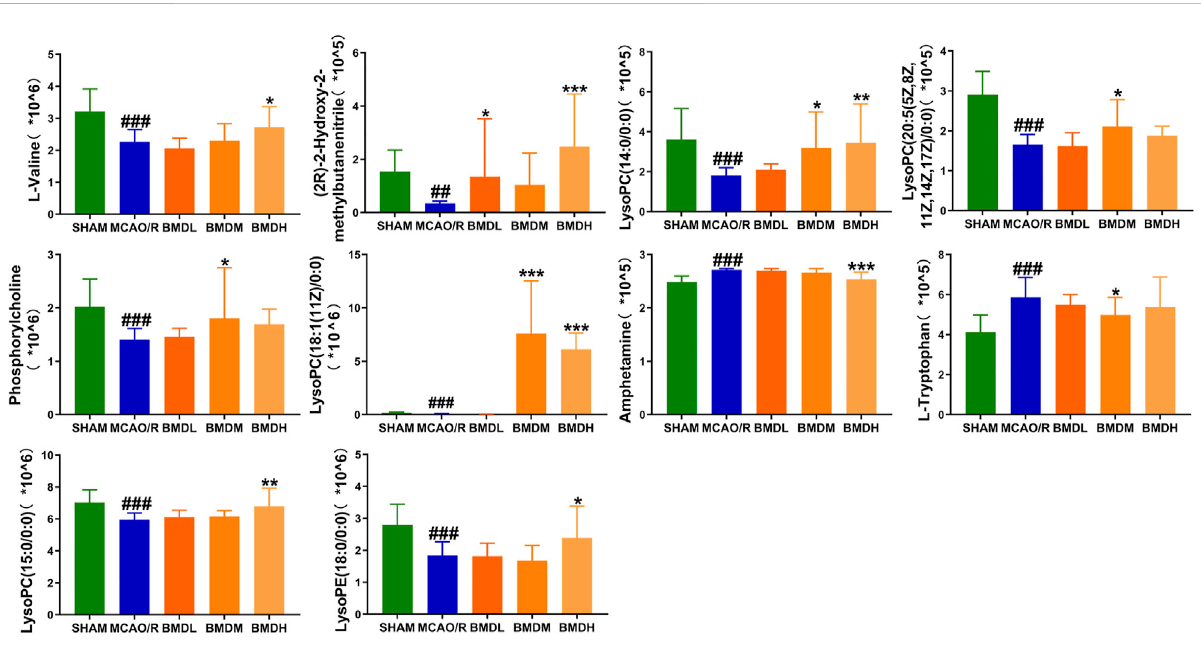
FIGURE 9 DifferentialmetabolitechangesinMCAO/RwithBMDinterventioninserum.Datawereexpressedasthemean±SD. *p < 0.05, **p < 0.01, ***p